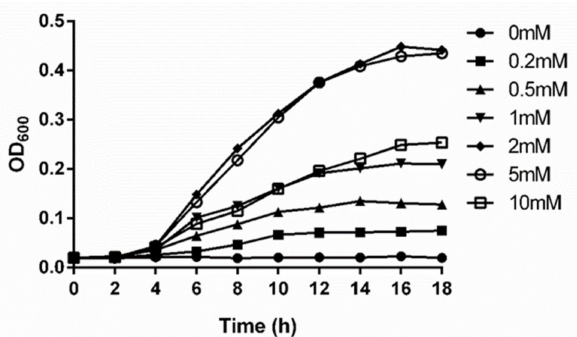
Figure 1. The growth rates of P. polymyxa WLY78 cultivated in minimal medium with L-serine as the sole nitrogen source. L-serine concentrations ranged from 0 to 10 mM. Results are represen- tative of at least three independent experiments, mean values were calculated from three sets of independent experiments.